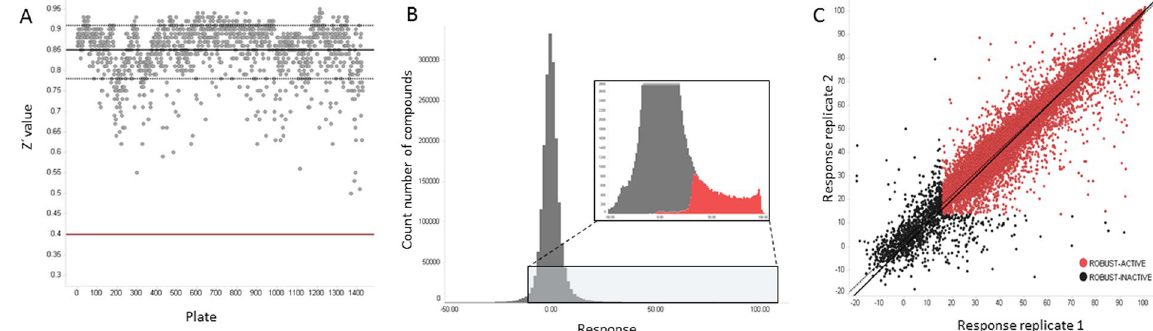
Figure 1. Performance metrics of HTS on PfPKG. ( A ) Plate number is plotted against the resulting Z ′ 61 . The red line corresponds to the minimum required value to deem the assay of good quality and the thick black line corresponds to the mean value of 0.85. ( B ) Distribution of the percentage inhibition in the 10 μ M concentration assay for the 1.7 million compounds. Compounds were selected above the cut-off of 30% inhibition (in red). ( C ) Correlation of the confirmation step tested in duplicate against WT PfPKG.